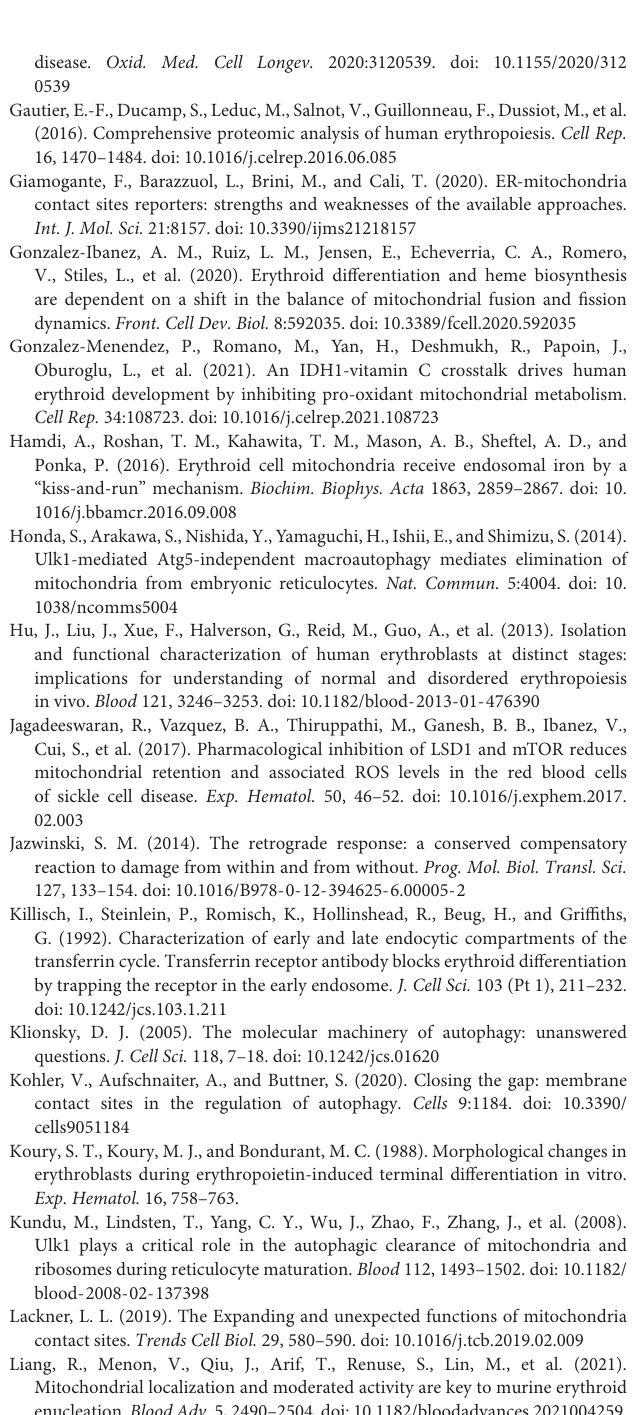
Supplementary Figure 2 | Electron micrographs of BasoE. Supplementary Figure 3 | Electron micrographs of PolyE. Supplementary Figure 4 | Electron micrographs of OrthoE. Supplementary Figure 5 | Mitochondrial morphology in erythroblasts. Representative images of rounded and elongated mitochondria in erythroblasts with inserts of rounded (R) or elongated mitochondria